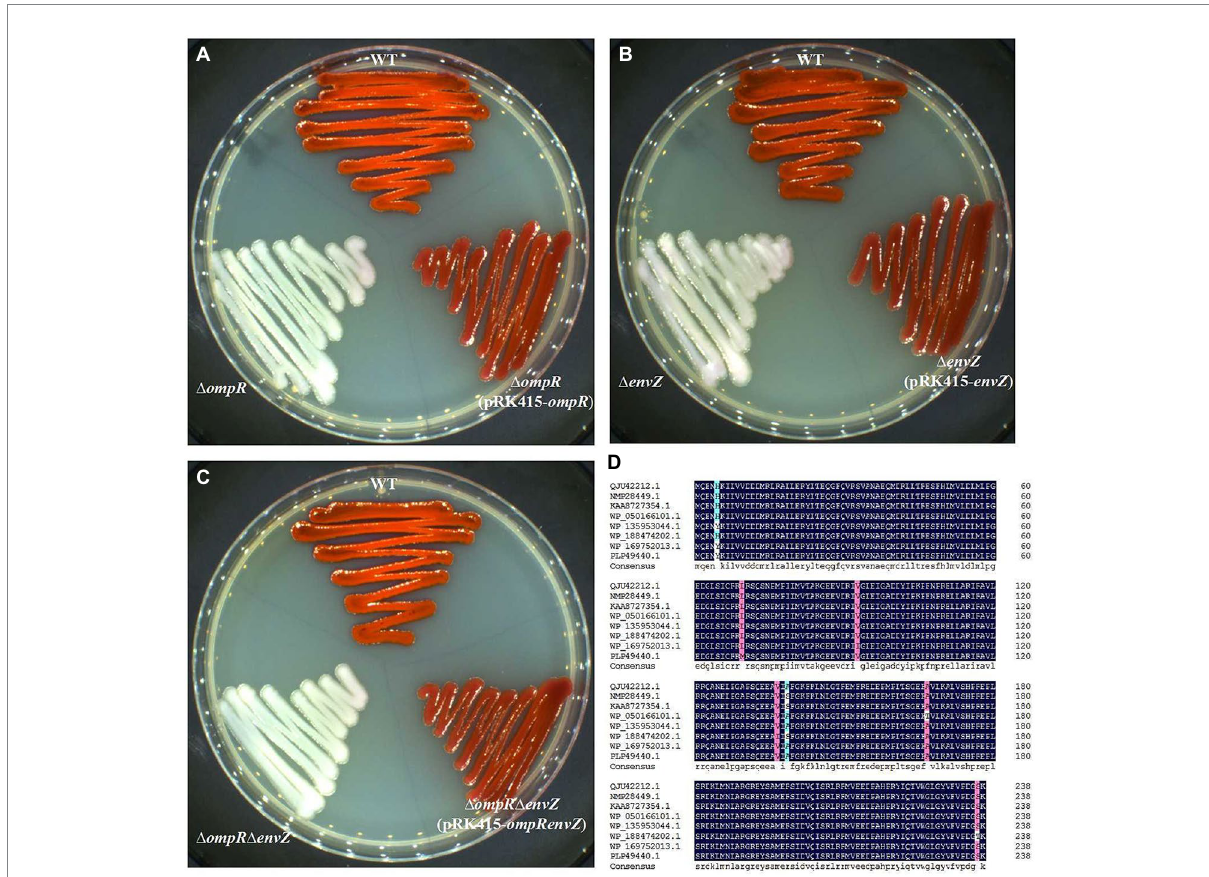
FIGURE 1 EnvZ/OmpR two-component system and its effect on the prodigiosin-producing ability of S. marcescens FZSF02. (A) Prodigiosin-producing ability of strain WT (wild-type strain of S. marcescens FZSF02), and strain ∆ ompR (in frame deletion of ompR of FZSF02), complementary strain ∆ ompR (pRK415- ompR ). (B) Prodigiosin-producing ability of strain WT (wild-type strain of S. marcescens FZSF02), ∆ envZ (in frame deletion of envZ of FZSF02) and complementary strain ∆ envZ (pRK415- envZ ). (C) Prodigiosin-producing ability of strain WT (wild-type strain of S. marcescens FZSF02), strain ∆ ompR ∆ envZ (in frame deletion of envZ and ompR of FZSF02) and complementary strain ∆ ompR ∆ envZ (pRK415- ompRenvZ ). All strains were incubated on LB agar plates at 27 ° C for 48 h. (D) Multiple sequence alignment of OmpR homologies to analyze its high conservation. Sequences chosen for this analysis were from S. marcescens FZSF02 (QJU42212.1), R. aceris (NMP28449.1), E. americana (KAA8727354.1), Y. enterocolitica (WP_050166101.1), C. youngae (WP_135953044.1), H. psychrotolerans (WP_188474202.1), E. coli (WP_169752013.1), and K. pneumoniae